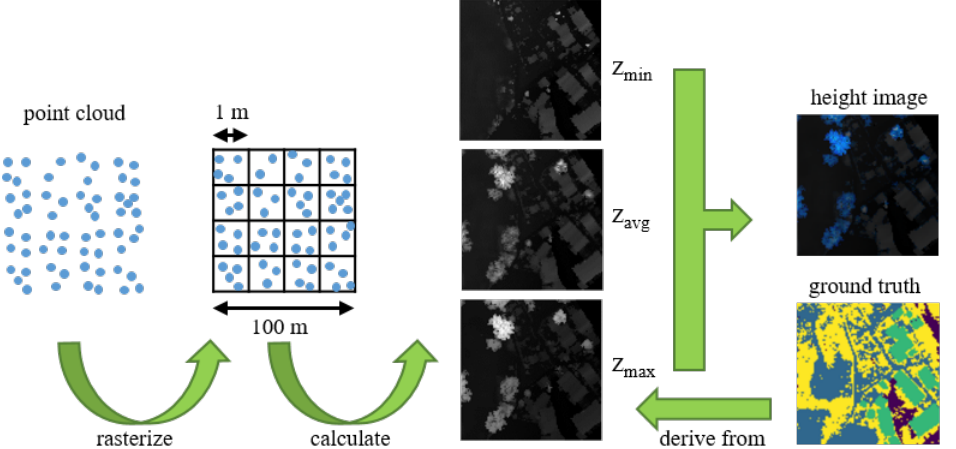
Figure 2. Process chain to create height images. For this figure, the final artificial 3-channel height image is rendered as normalized RGB image. The ground truth is divided into four classes: no data (purple), ground (blue), building (green) and non-ground